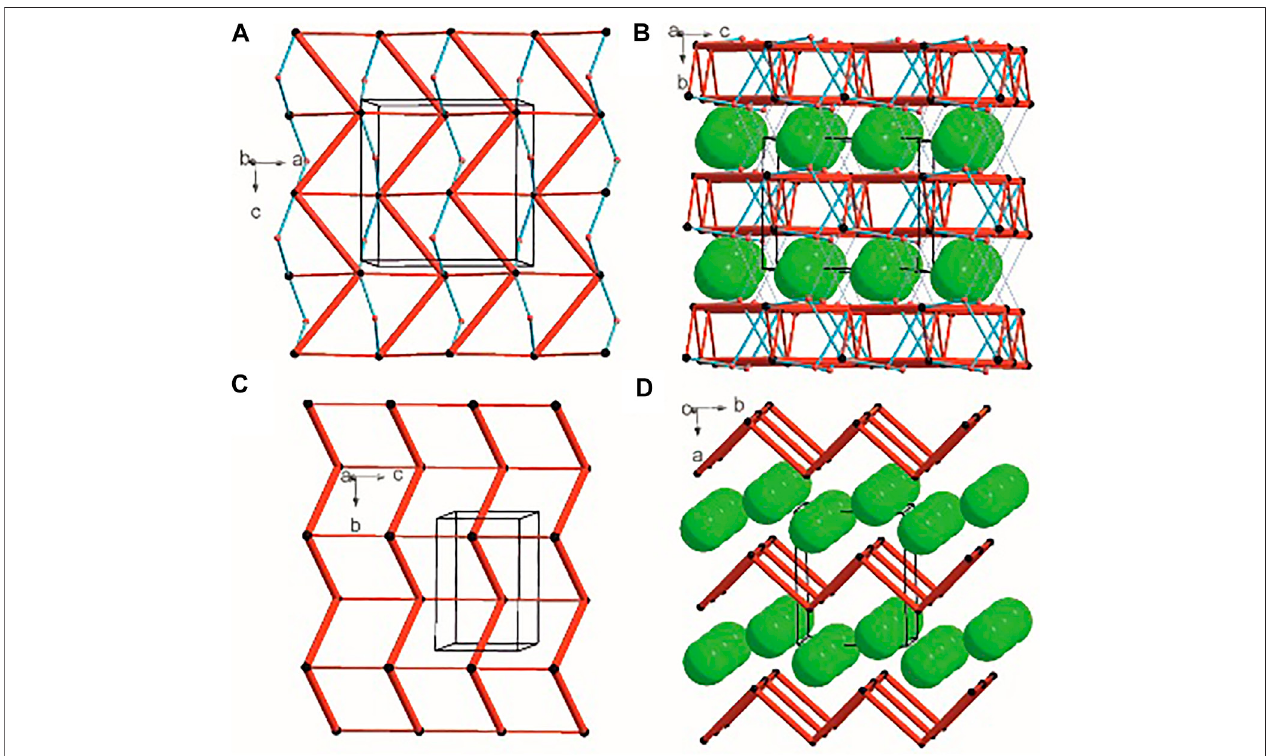
FIGURE 12 | Graph representation of the crystal structure of 1 and 2 showing LSAMs (A,C) and their packing (B,D) . The black dot represents cations ’ center of gravity, red dot – positions of water molecules while green spheres positions of chloride anions. Thick red rods show the most important N-H ... O interactions, the thin ones — secondary interactions between cations while blue lines stand for interactions with water